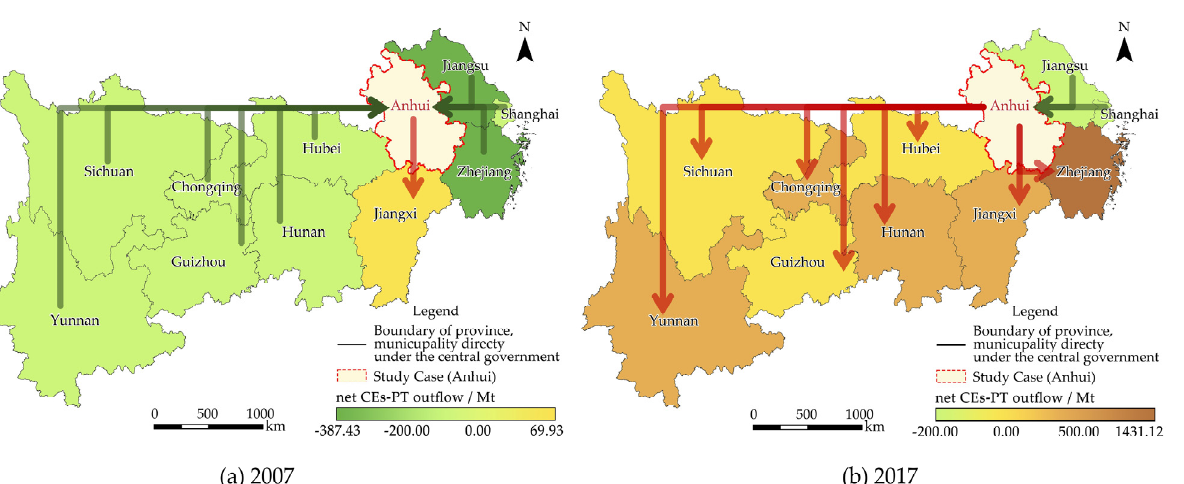
Figure 5. Net ECEs-IPT outflow as a rate of total CEs ( a ) and net CV outflow as a rate of total regional output ( b ) in Anhui among the YREB from 2007 to 2017.